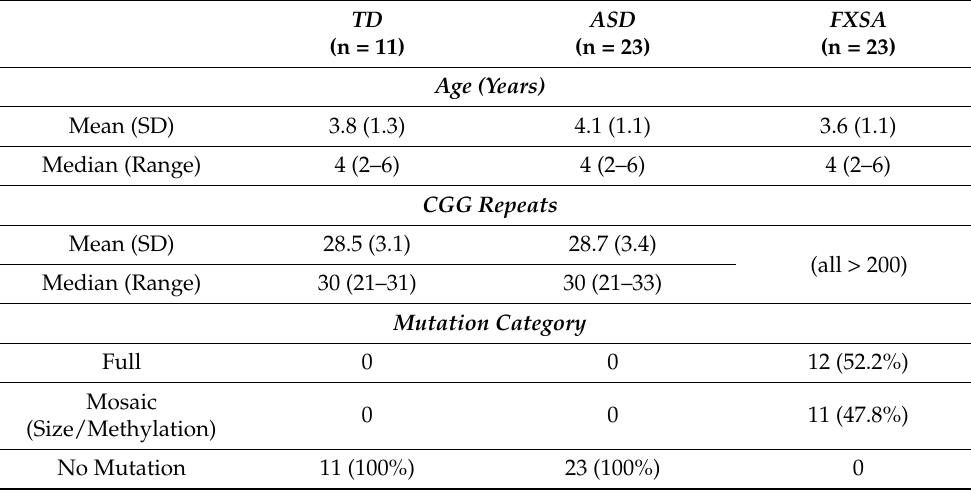
Table 1. Demographic and molecular characteristics of